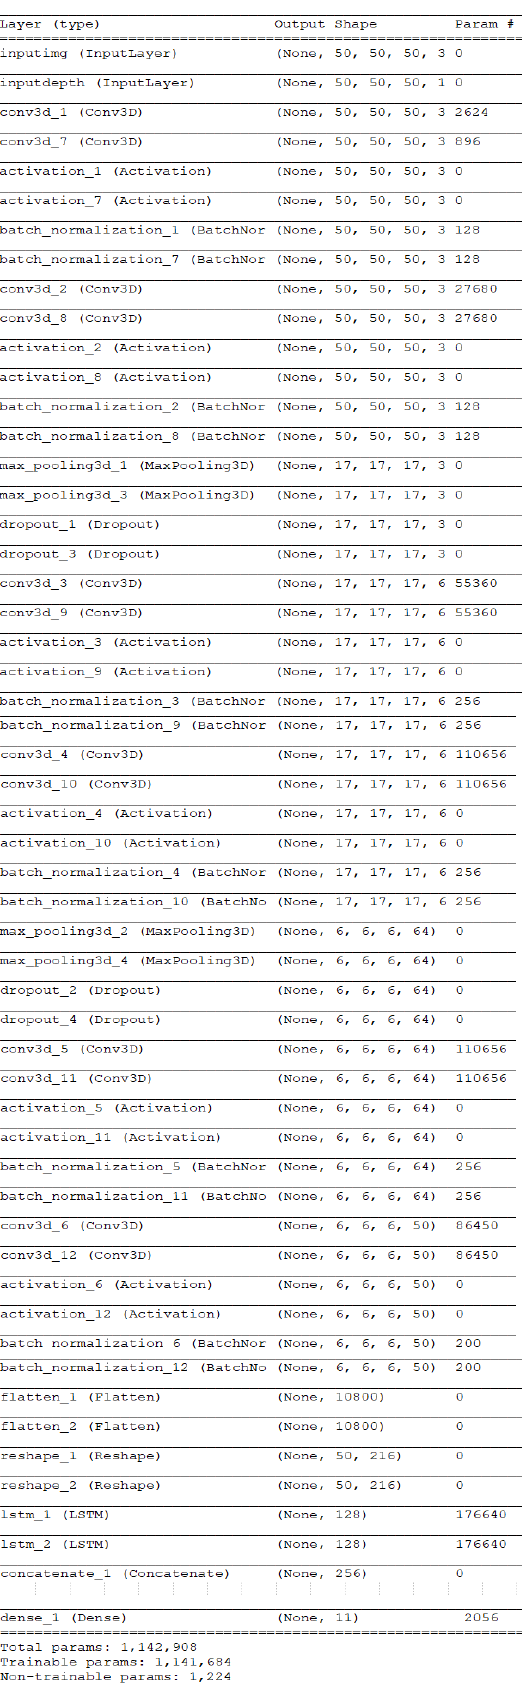
Figure A4. Dual-3DCNNLSTM Output shape and number of weights in each layer.